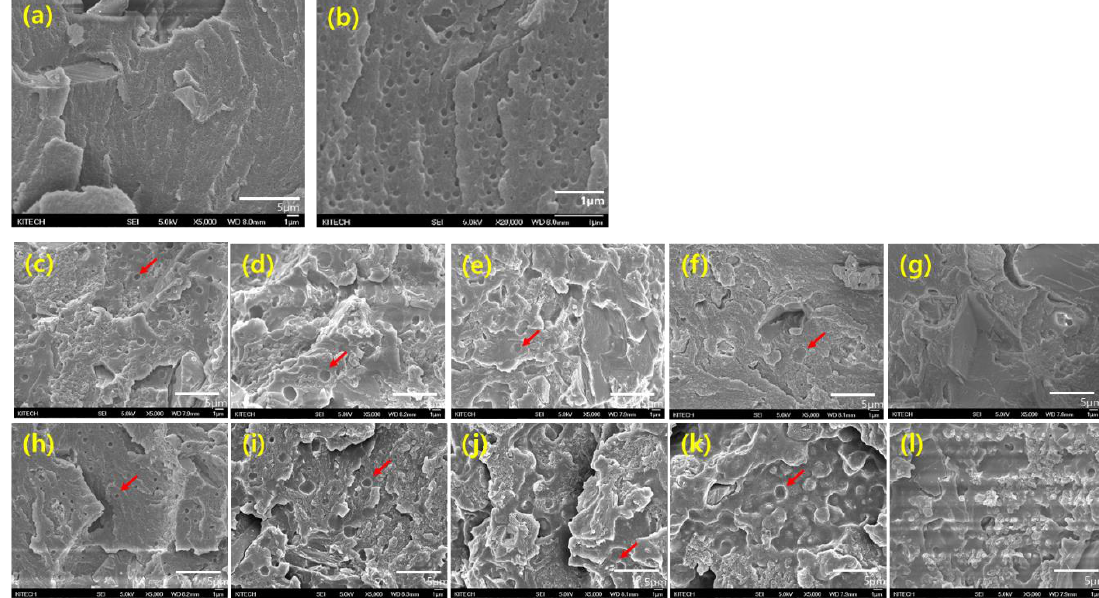
Figure 11. SEM micrographs of the fractured surfaces of the control and modified epoxy adhesives obtained from the IWP test (5000 × magnification except ( b )): ( a ) control; ( b ) control (20,000 × magnification); ( c ) 5 wt % PTPU; ( d ) 10 wt % PTPU; ( e ) 15 wt % PTPU; ( f ) 20 wt % PTPU; ( g ) 30 wt % PTPU; ( h ) 5 wt % CTBN; ( i ) 10 wt % CTBN; ( j ) 15 wt % CTBN; ( k ) 20 wt % CTBN; and, ( l